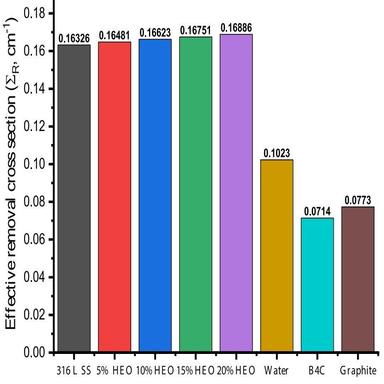
Effective removal cross section (ƩR) of the samples.